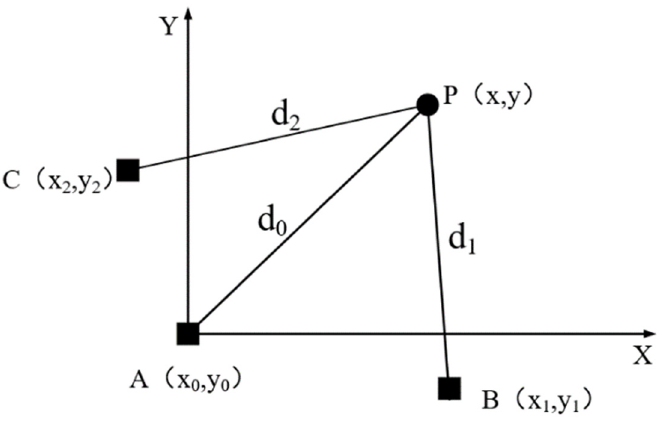
Figure 2. Three station time difference positioning model.